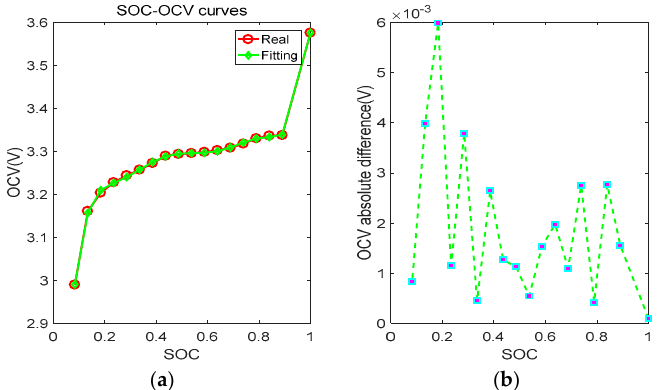
Figure 2. Experimental and curve ‐ fitted state of charge–open circuit voltage (SOC ‐ OCV) correlation: ( a ) nonlinear relationship between SOC and OCV; ( b ) OCV absolute difference between real and fitting at different SOCs.